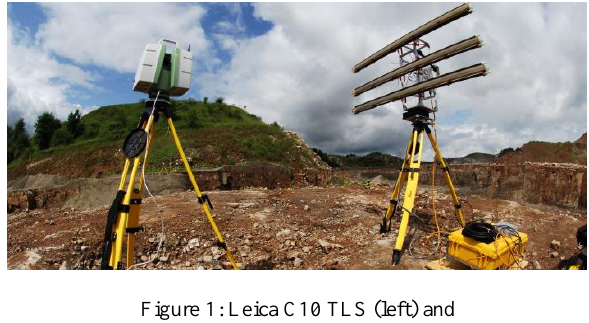
Figure 1: Leica C10 TLS (left) and GAMMA RADAR scanner